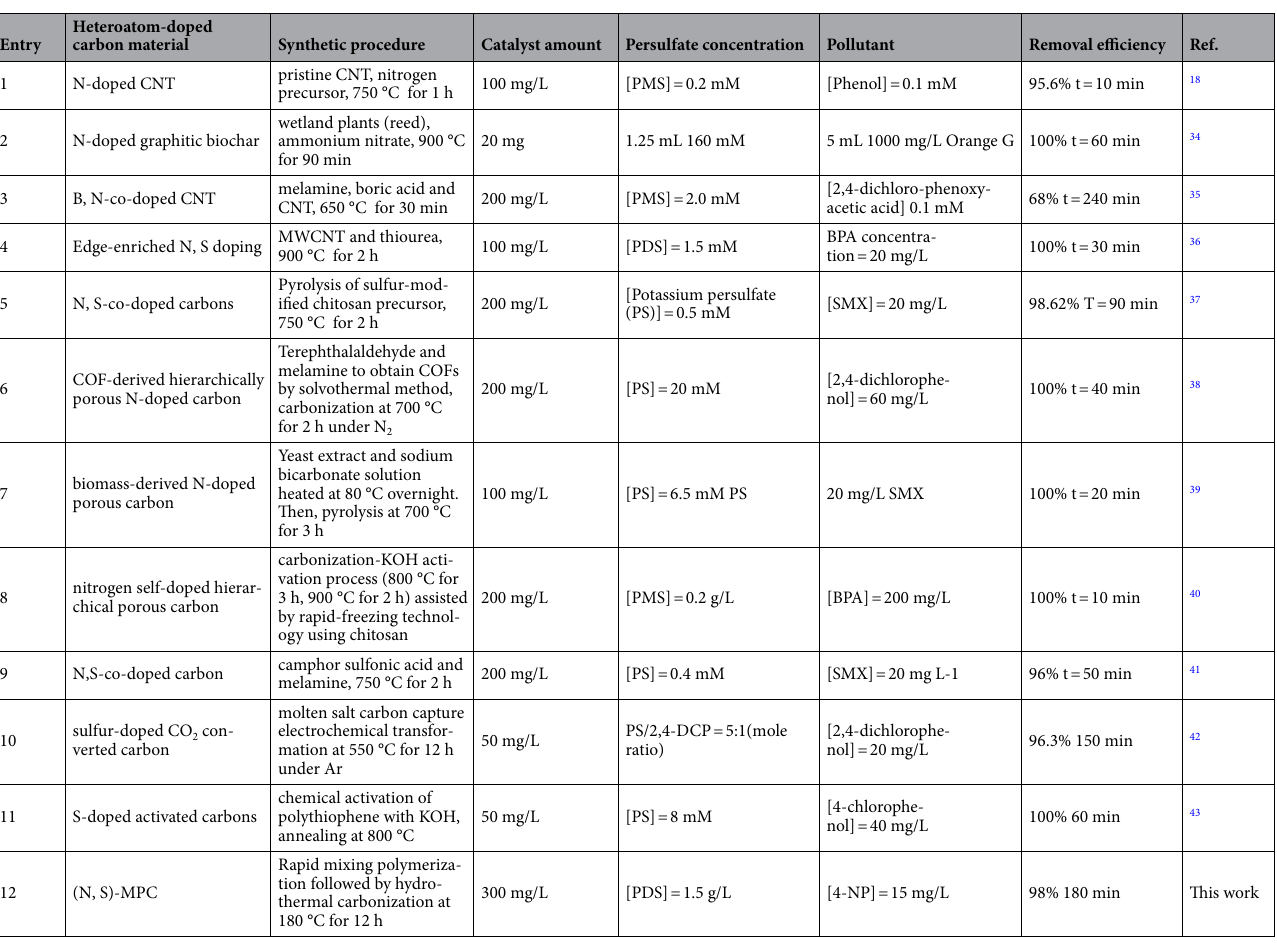
Table 2. Comparing the performance of various metal-free carbon-based materials for persulfate